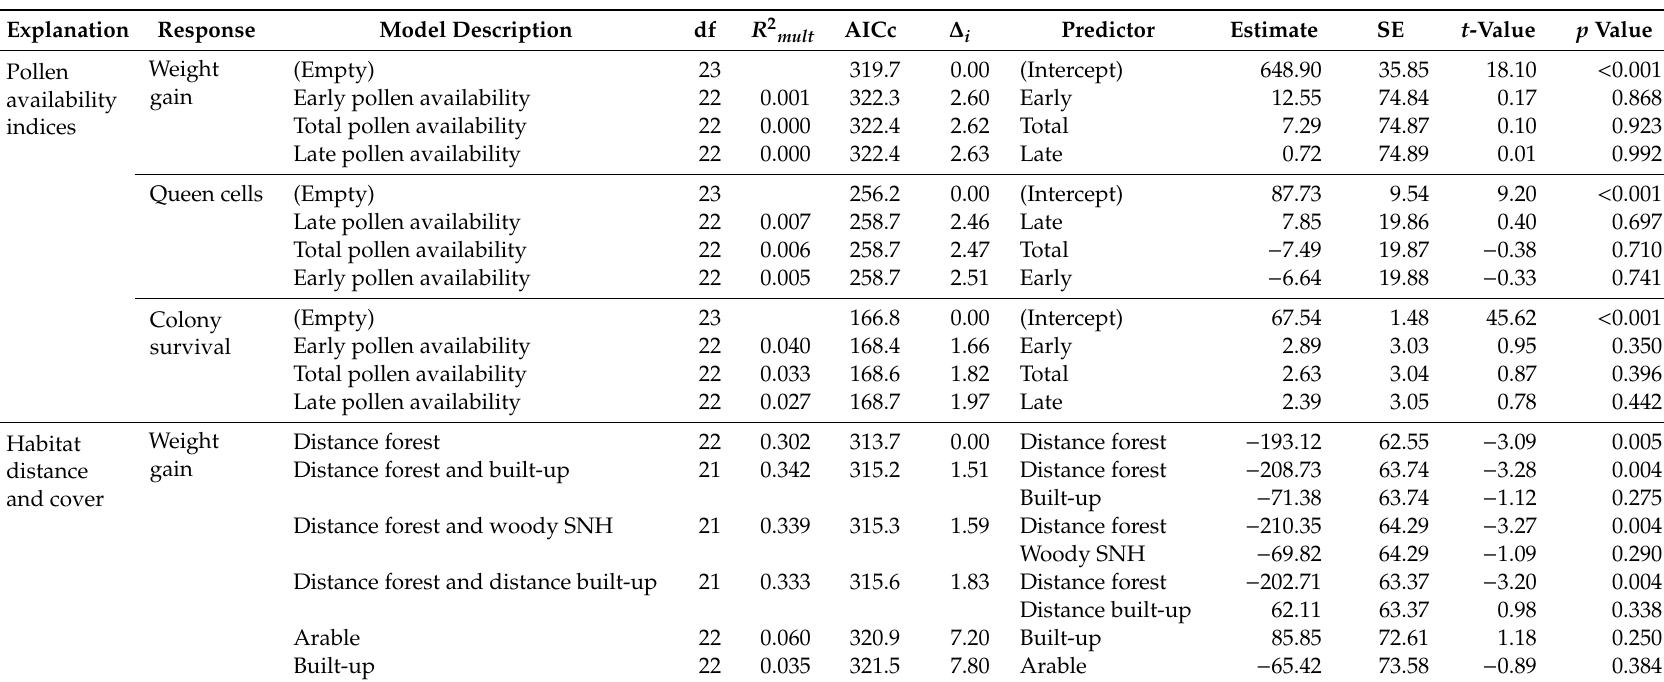
Table 1. Comparison of models explaining bumblebee colony response variables with pollen availability indices, classical habitat maps, and single resources (see main text for description of mapping approaches). The abbreviation “SNH” is used for “Semi-natural habitat”. The Akaike second-order Information Criterion (AICc) and the dredge function from the MuMin package [53] were used to select the best models ( ∆ i < 2). Delta weight ( ∆ i ) is the di ff erence between the AICc of the model and the best model. Best models containing pollen availability and important predictors using habitat maps or single pollen resources are displayed regardless of AICc values (see main text). Models listed below a dashed line are not included in the best model set ( ∆ i < 2). Variables were standardized